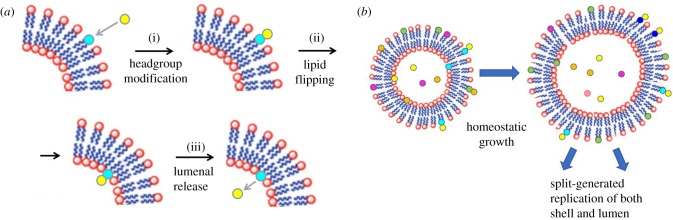
Example features of the Metabolic GARD (M-GARD) model. (a) The reactions shown are assumed to be non-enzymatically catalysed by other lipids as part of a GARD mutually catalytic network, analogous to that of the standard GARD model. (i) Lipid headgroup is modified on the outer leaflet of the bilayer, via a covalent reaction with an extraneous hydrophilic compound (yellow); (ii) non-covalent lipid flipping to the inner leaflet; (iii) covalent clipping that releases the hydrophilic compound into the vesicle aqueous lumen. This progression is equivalent to catalysed transport that confers chemical specificity on lumen enrichment. In modified form, if a high-energy lipid (e.g. with oligophosphate headgroup) is involved as a reactant, this could constitute a primitive form of active transport. (b) The reactions in a could underlie a coveted scenario in which under modified GARD compositional reproduction dynamics homeostatic growth and fission could lead to the generation of progeny with faithful copying of the composition of both the bilayer shell and the enclosed aqueous lumen.